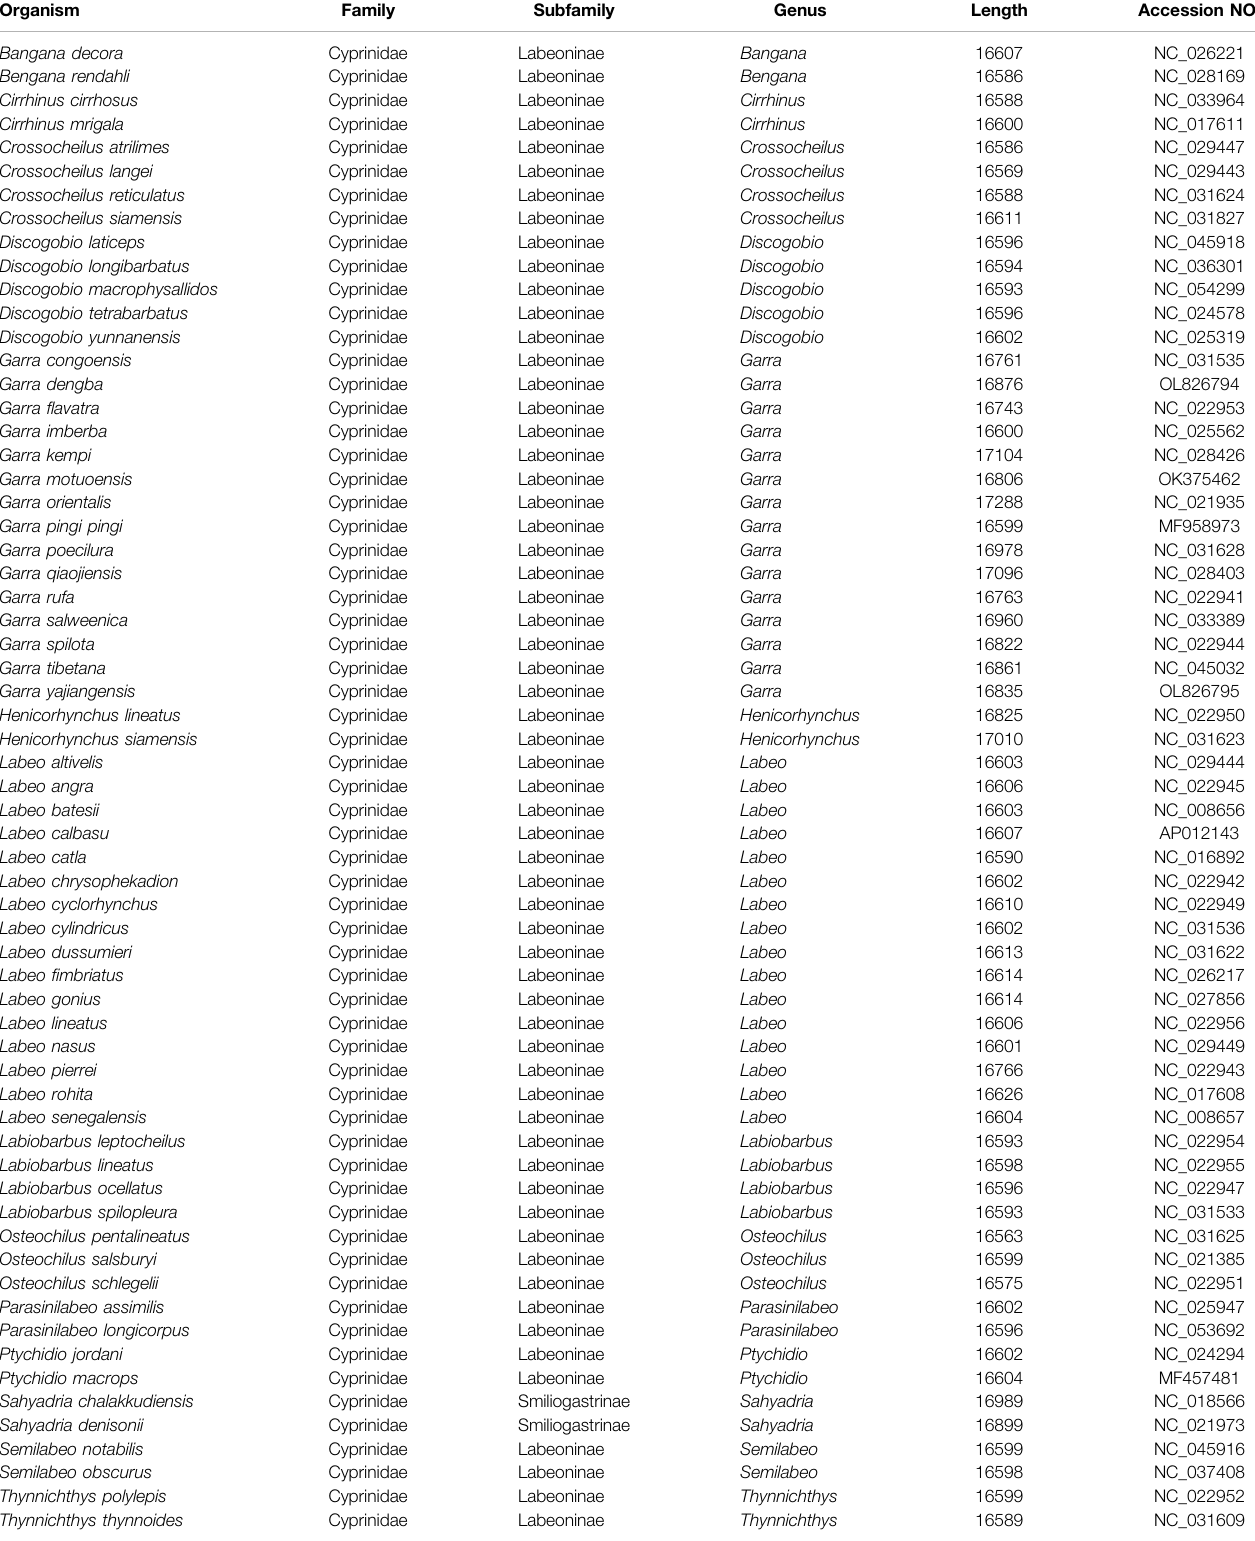
TABLE 3 | List of 61 Labeoninae species and two outgroups used in this paper.